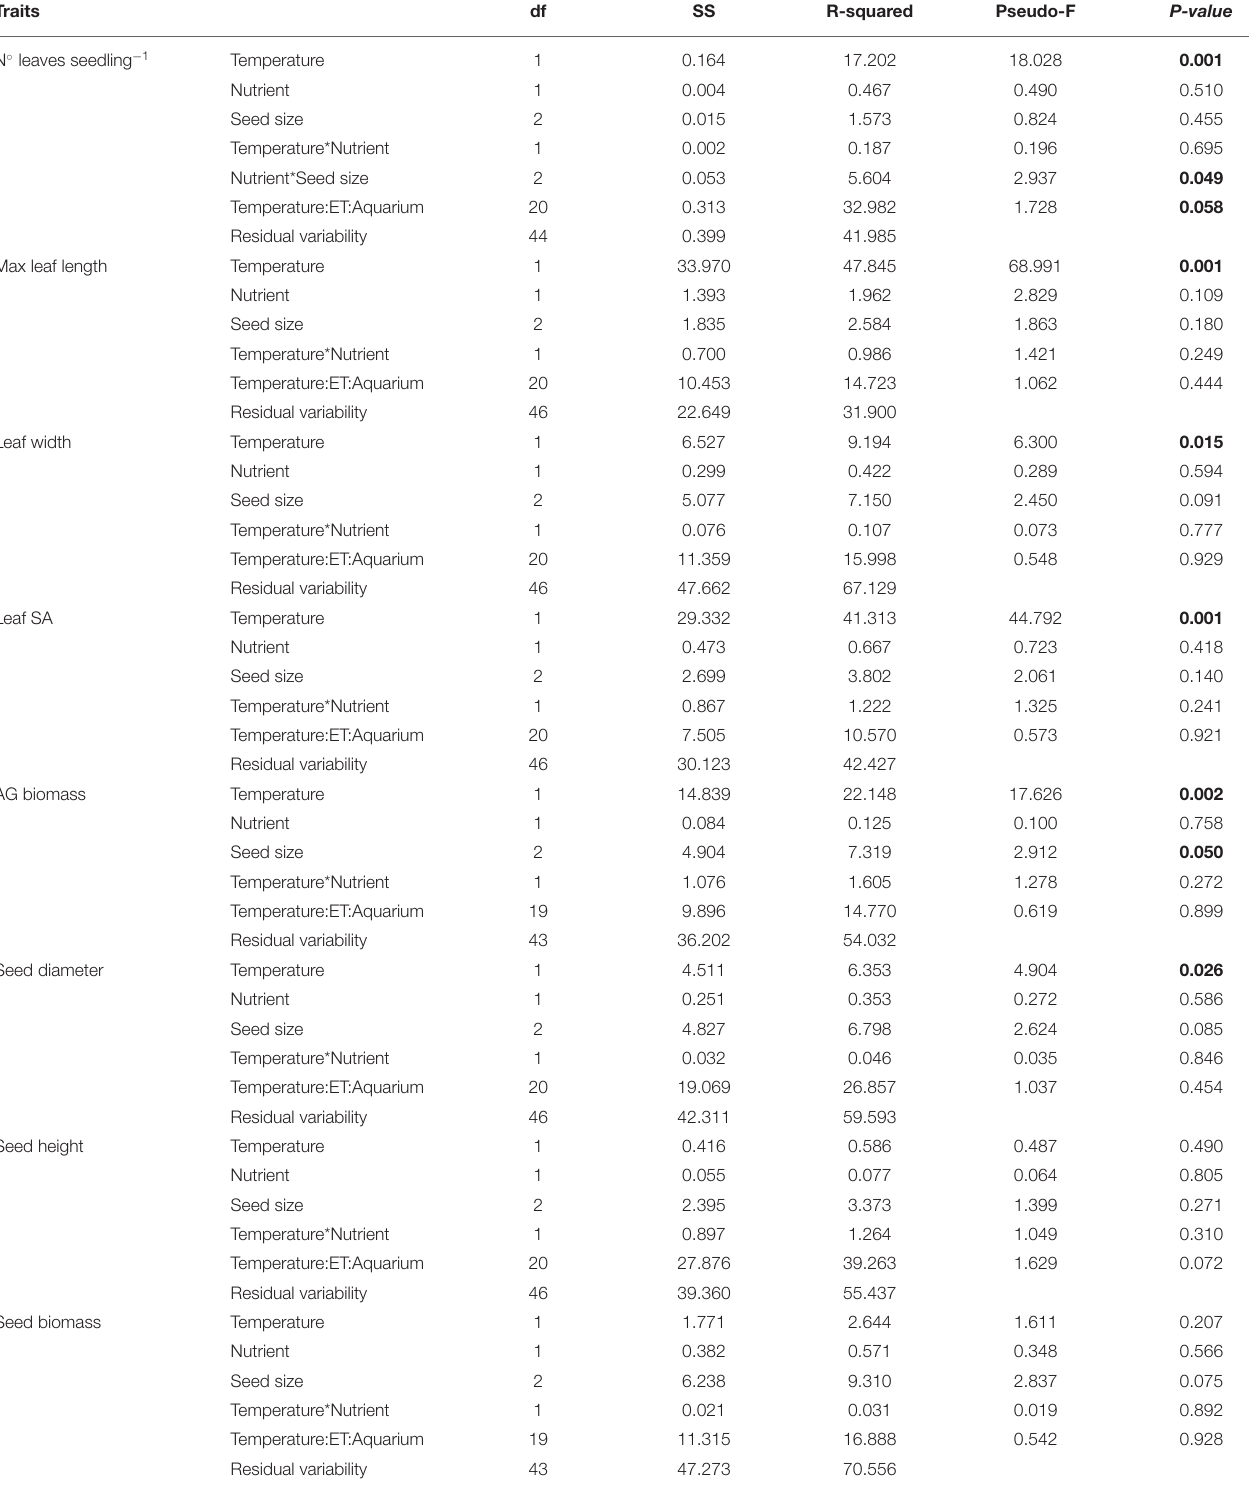
TABLE 4 | Results of the permutational analysis of variance (PERMANOVA) of the effects of temperature and nutrient treatments on the morphological traits of Enhalus acoroides seedlings included in Table 2, with the exception of number of roots. Traits df SS R-squared Pseudo-F P-value N ◦ leaves seedling −